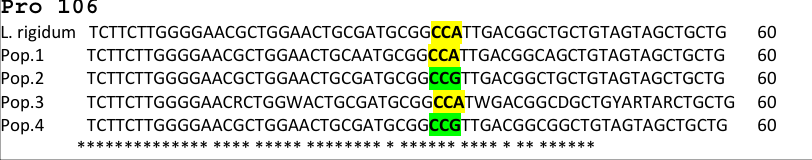
Figure 3. Nucleic acid sequences alignment of the 4 populations studied. CCA silent mutation is highlighted in yellow. CCG silent mutation is highlighted in